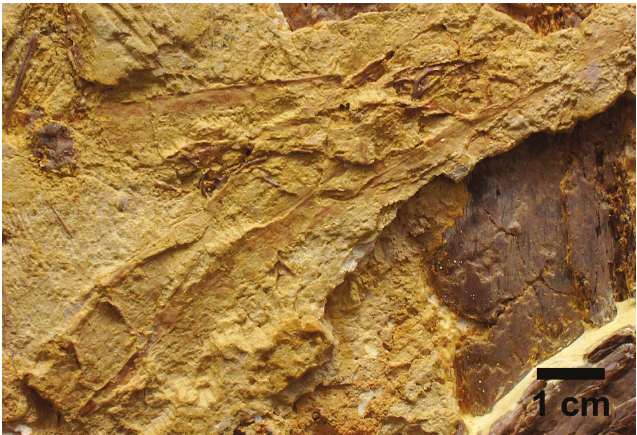
Figure 4. Impression of the possible premaxillary apex of the skull/rostrum, photographed with the protective Plexiglas